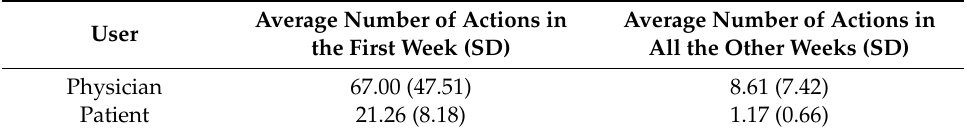
Table 7. Mean and standard deviation of the number of actions in the first week compared to all the other weeks.